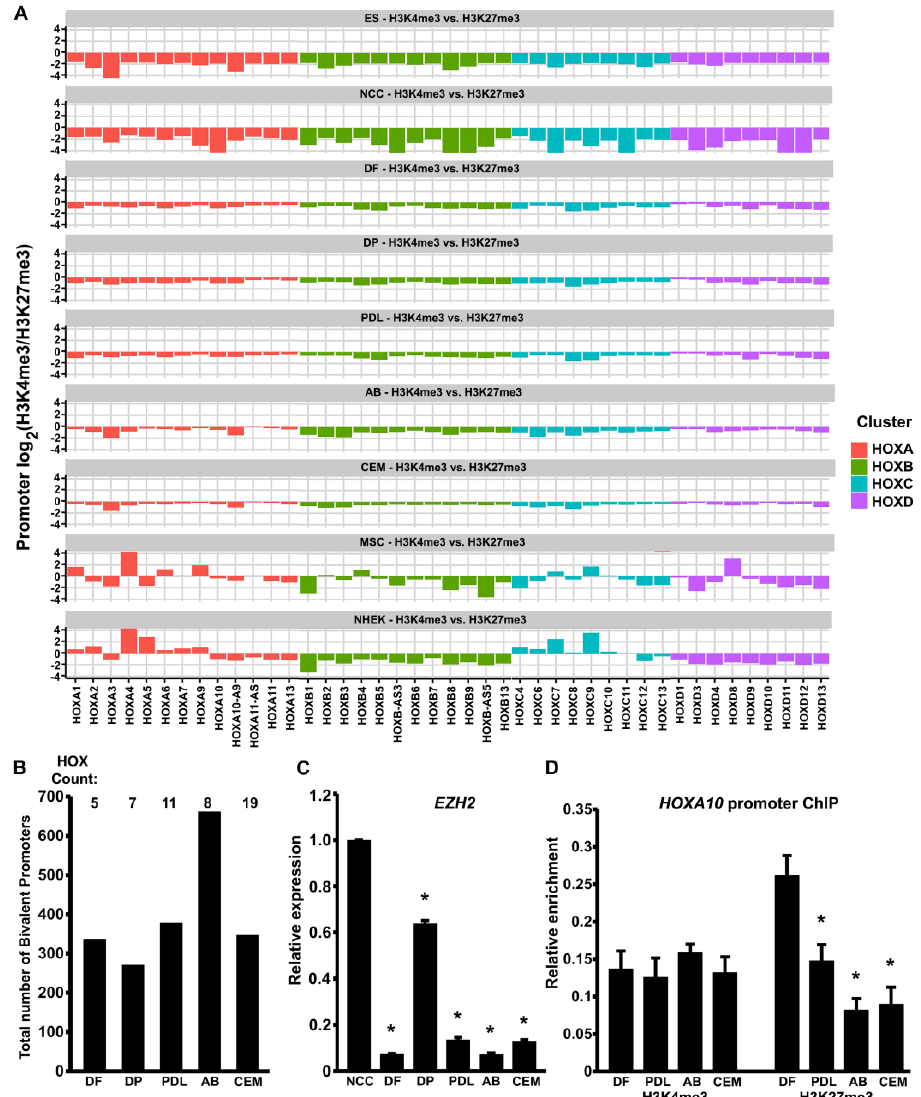
Figure 2. HOX gene promoters are marked by a bivalent signature in odontogenic progenitors. ( A )